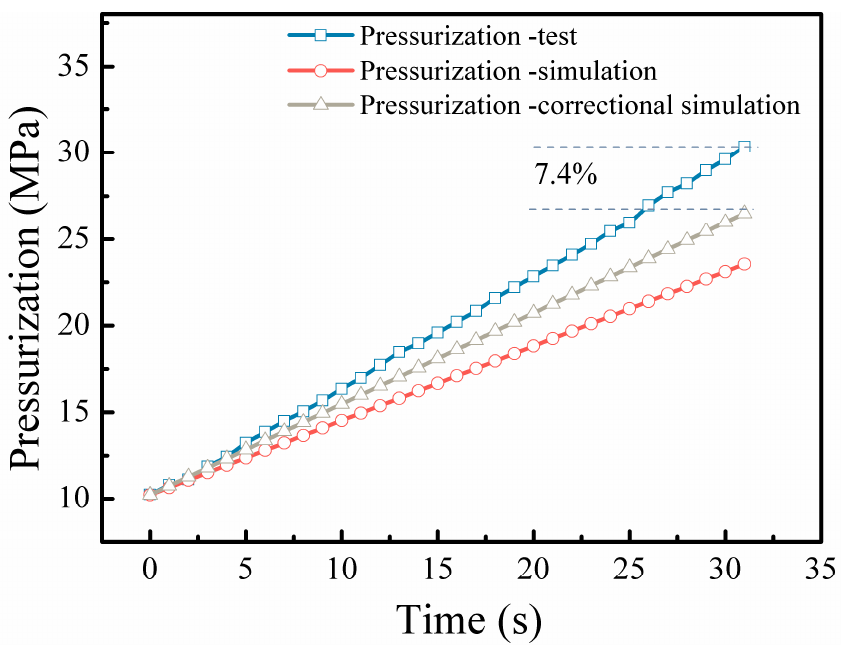
Figure 19. The test pressurization curve of 10~30 MPa and the simulated pressurization curve.